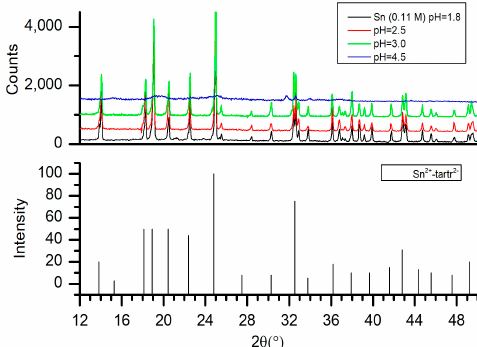
Figure 7. XRD diffraction patterns of precipitates isolated from the Sn- single metal and mixed Figure 7. XRD di ff raction patterns of precipitates isolated from the Sn- single metal and mixed Fe(III)–Sn(II) electrolytes at the different pH values. Fe(III)–Sn(II) electrolytes at the di ff erent pH